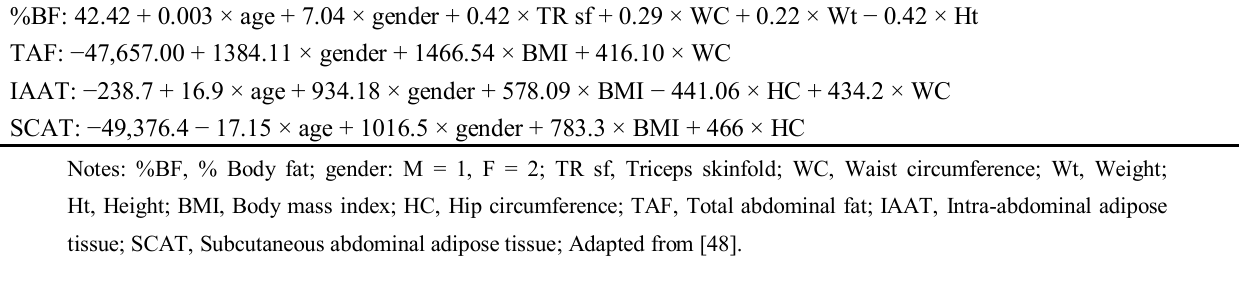
Table 3. Predictive equations for estimation of various body fat depots in Asian Indians. Variable predictive